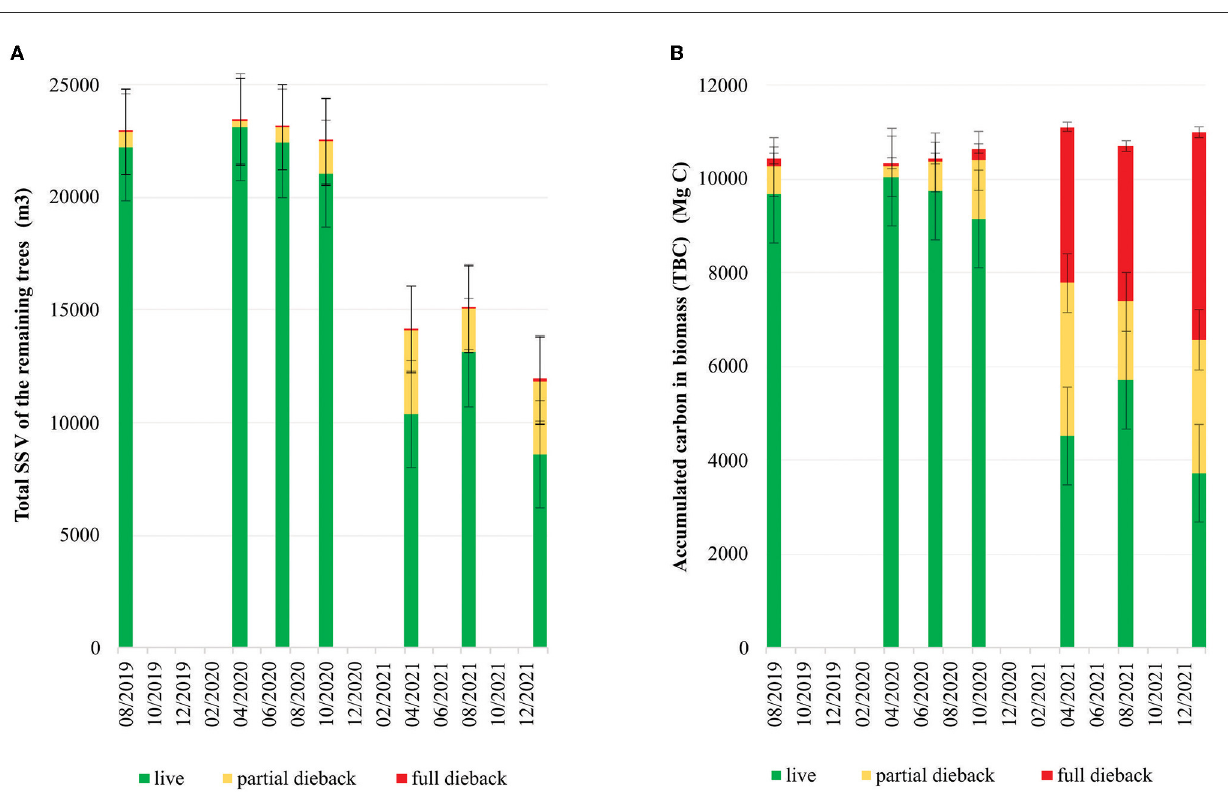
FIGURE7 (A) Changes in the standing stock volume (SSV) of the remaining trees. (B) Accumulated total biomass carbon in the research area (200 ha) due to the dieback event in the mangrove ecosystem in East Lampung (August 2019–January